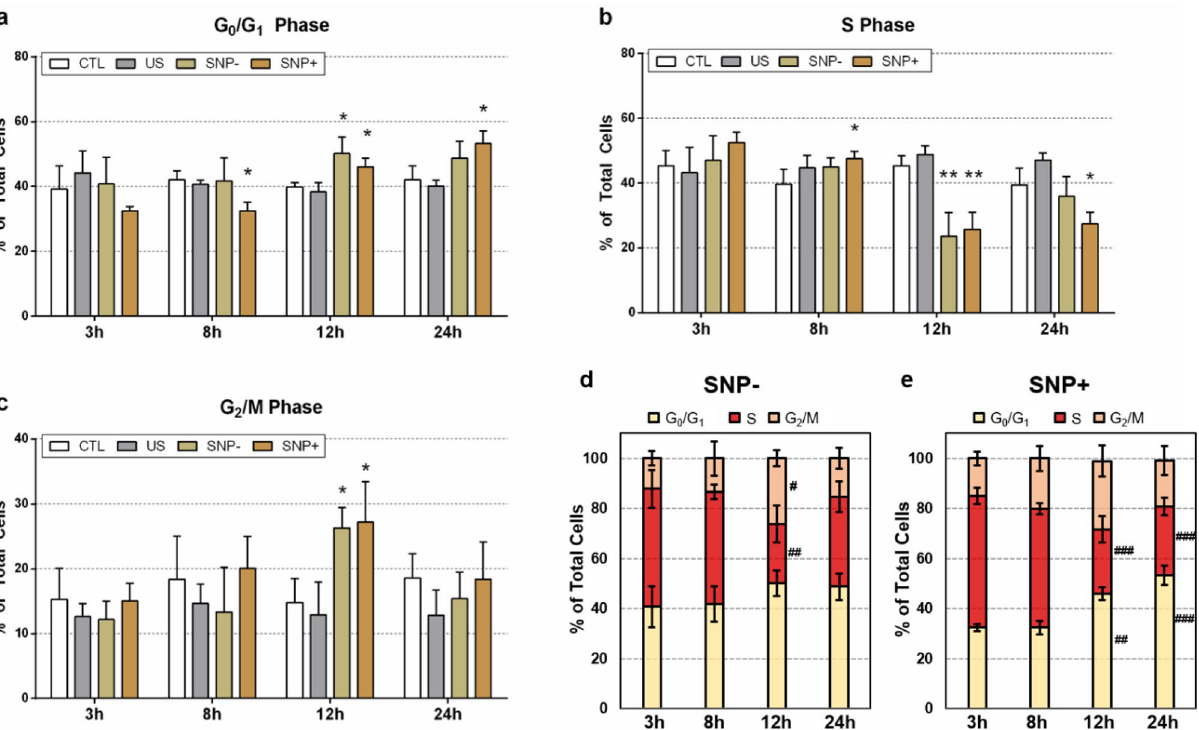
Figure 4. Time-lapsed cell cycle progression trends of four sorted cell groups (SNP+, SNP–, US, CTL) over a 24 h period. Percentages of cells in the following cell-cycle phases are shown at 3 h, 8 h, 12 h, and 24 h after exposure: (a) gap 0 or gap 1 (G 0 /G 1 ); (b) synthesis (S); (c) gap 2 or mitosis (G 2 /M). Cell cycle distribution at the four post-exposure time points are also plotted as stacked bar charts for (d) SNP– and (e) SNP+ cell groups. Population percentages were calculated based on the total number of viable cells. Results were presented as mean ± standard deviation. Data points were acquired from three experiments ( N = 3), each of which had 3 to 5 samples (*, **, and *** respectively denote p < 0.05, p < 0.01, and p < 0.001 versus CTL at the same time point. #, ##, and ### denote p < 0.05, p < 0.01, p < 0.001 versus the 3 h time point of the same group).